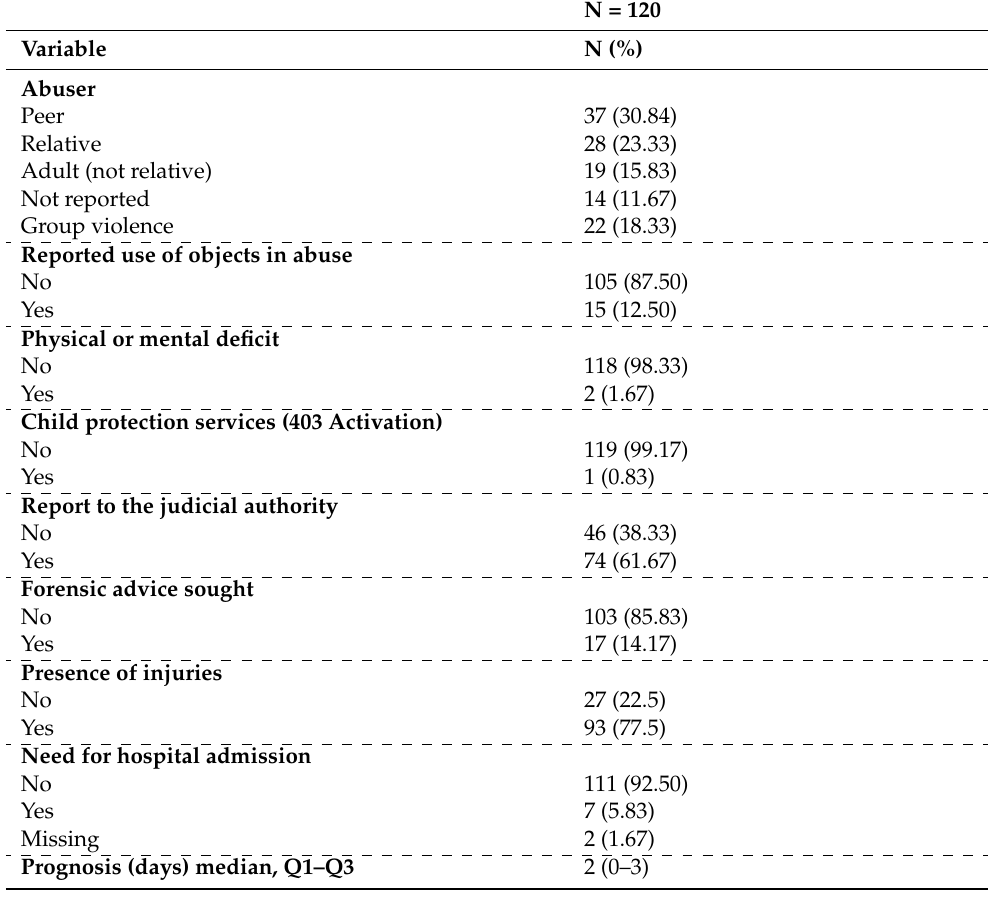
Figure 3. Distribution of foreign minors according to the country of origin. 3.2. Types of Abuse 50.00% of all cases analysed are attributable to peer abuse, 37.50% to physical abuse. Then, in 10.00% of the cases, minors were victims of sexual violence; finally, witnessing violence and negligence appear respectively in 1.67% and 0.83% of the events (Figure 4). Figure 4. Distribution of cases of mistreatment. 3.3. Maltreatment and Sexual Abuse in the Pre-COVID and COVID Period To understand the impact of the COVID pandemic on child abuse, a comparison was made on the type of violence in the pre-COVID and COVID-19 period. In the pre-COVID era, 45.16% of E.R. visits related to violence were for mistreatment and 11.29% for sexual